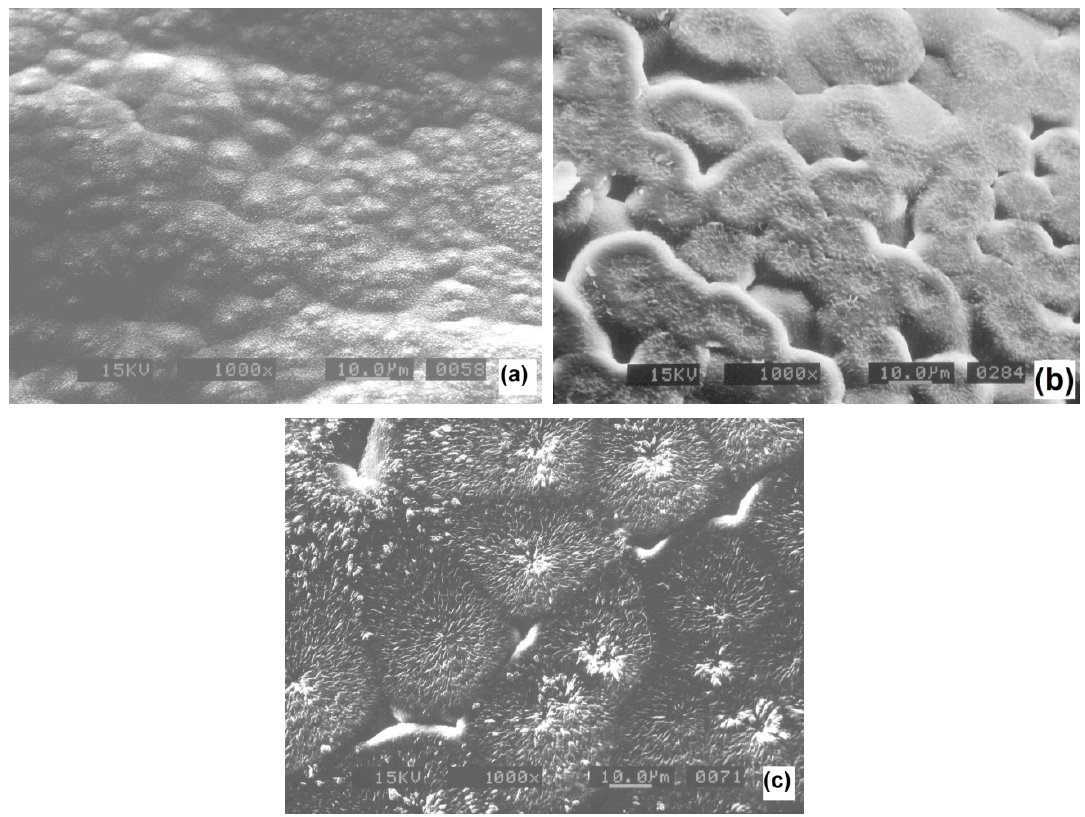
Figure 4. SEM micrographs of isothermally crystallized (30 min) PET-HMw at different temperatures: ( a ) 140 °C; ( b ) 200 °C; and ( c ) 220